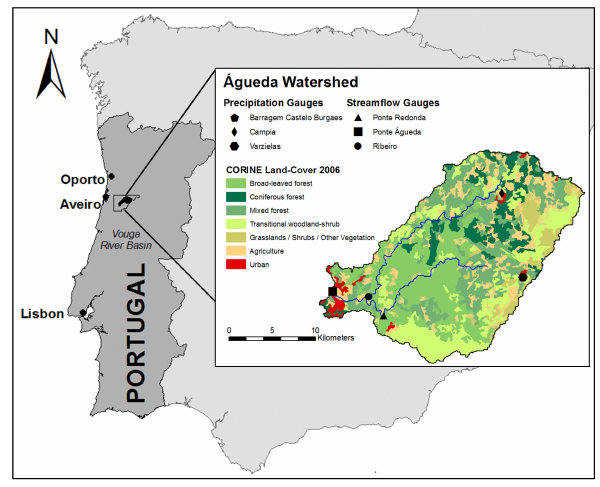
Figure 1. Location and land cover of the Águeda